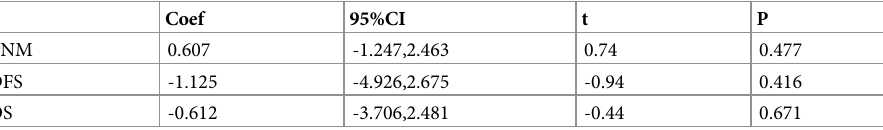
Table 3. The publication bias test including